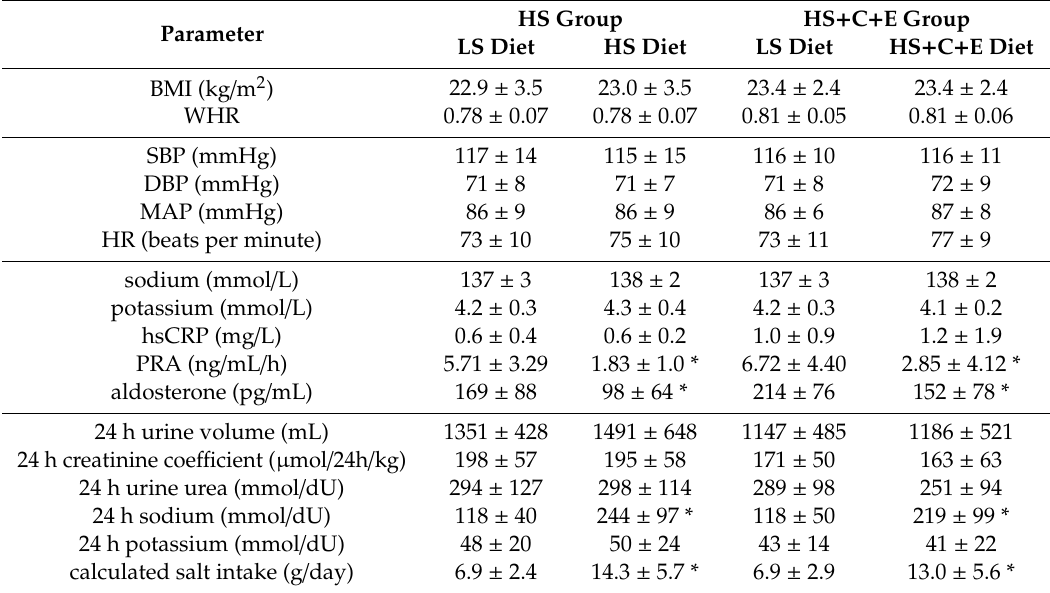
Table 2. The e ff ect of the 7-day high-salt diet without (HS group) or with vitamin C and E (HS + C + E group) intake on anthropometric, hemodynamic, and biochemical